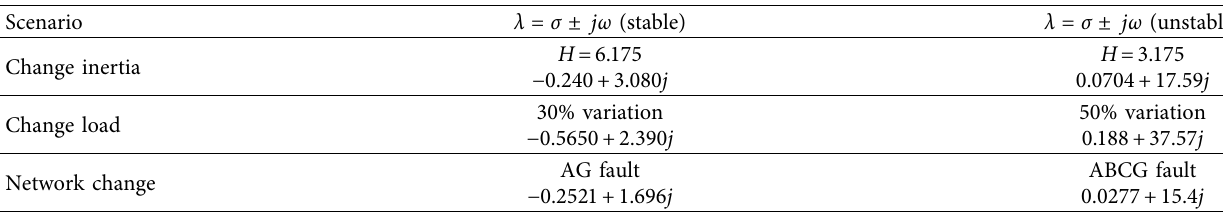
Table 4: Two-area system